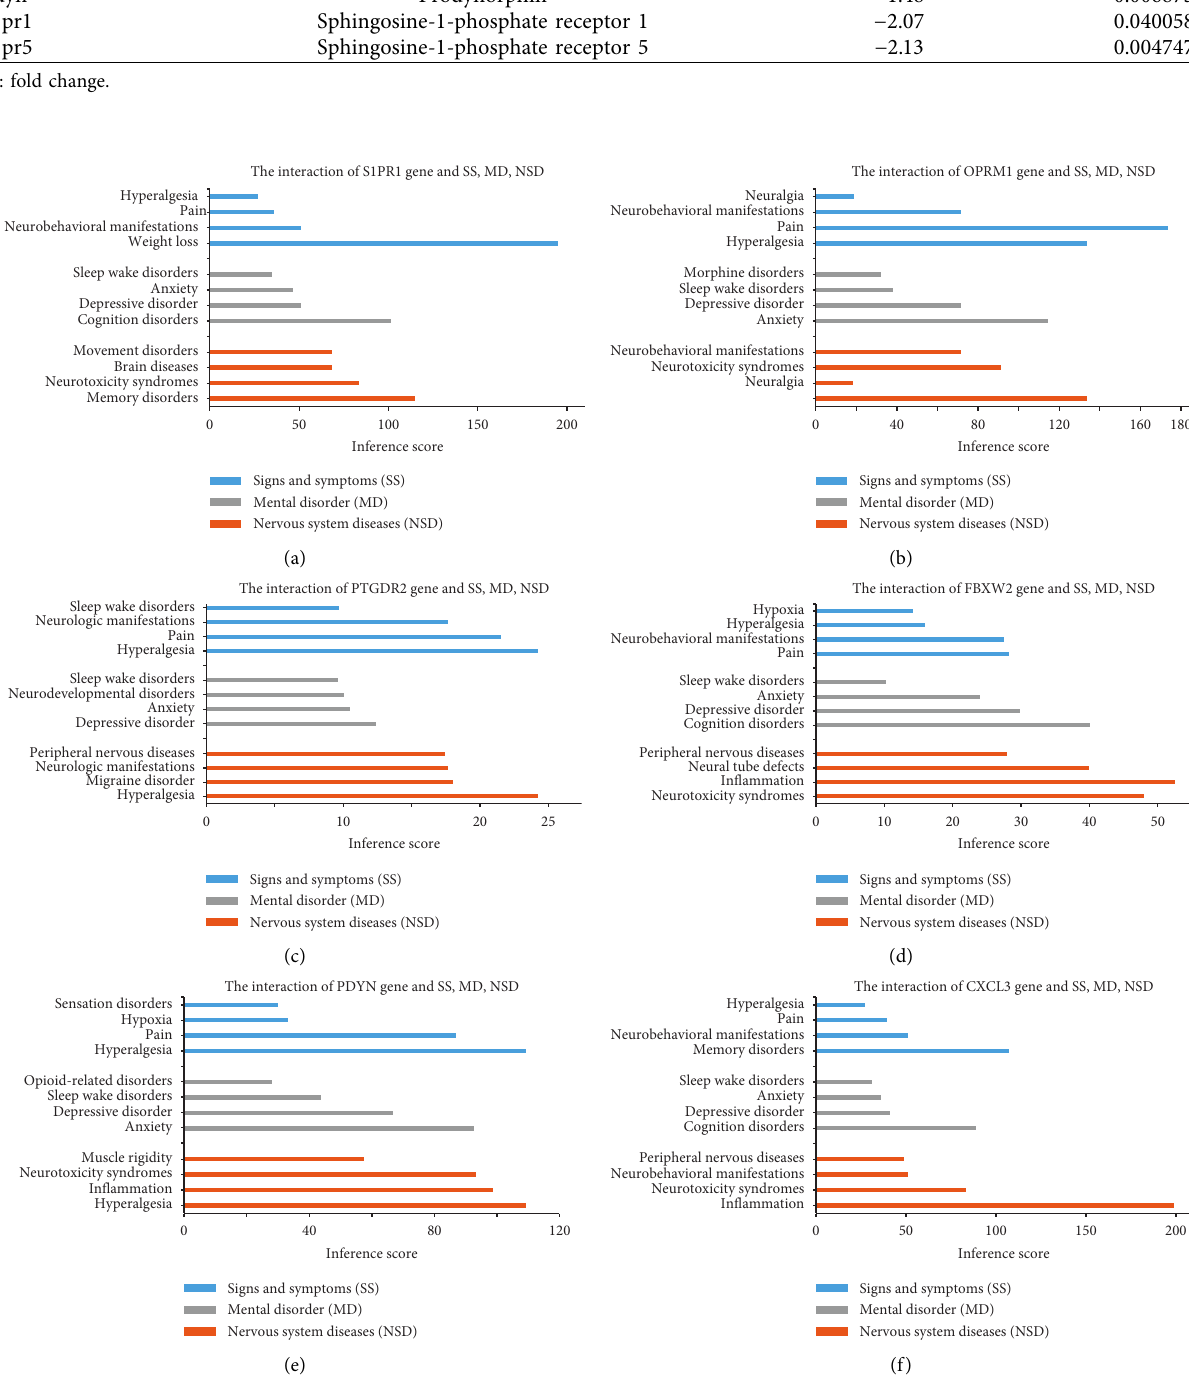
Figure 5: The hub gene analysis in CTD. (a) S1PR1, (b) OPRM1, (c) PTGDR2, (d) FBXW2, (e) PDYN, and (f)